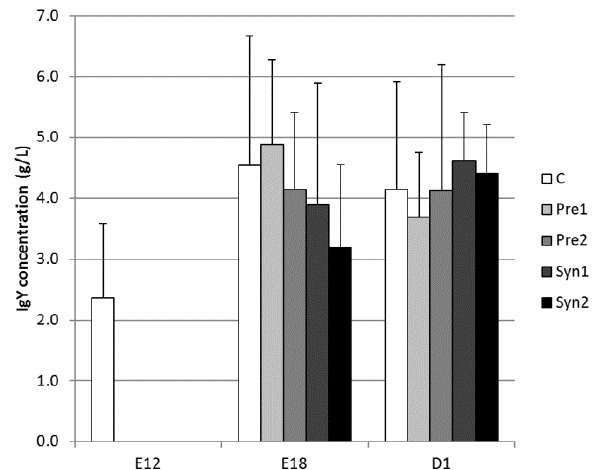
Figure 1. Yolk sac IgG (Y) concentration (mean ± SD) in chickens between the 12th day of